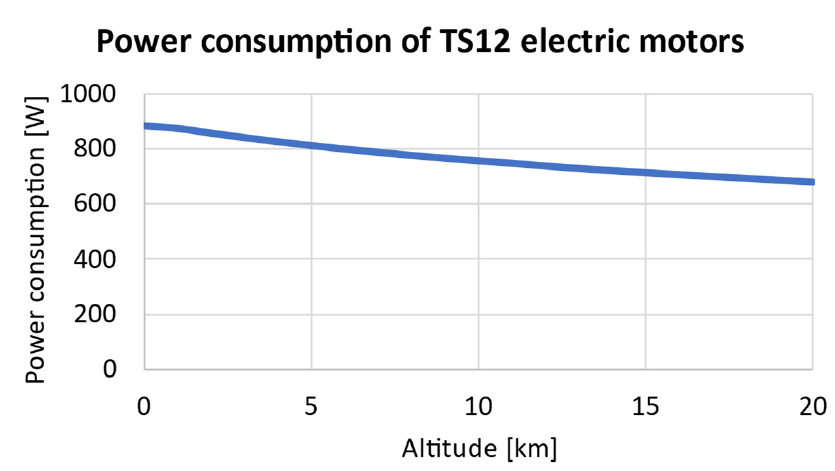
Figure 20. Power consumption of TS12 electric motors during climbing.